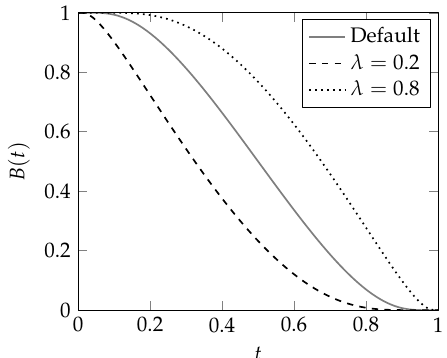
Figure 10. Plots of ERB-functions with varying balance parameters. The solid function is the default ERB ( λ = 0.5), the dashed function has λ = 0.2, and the dotted function has λ = 0.8.